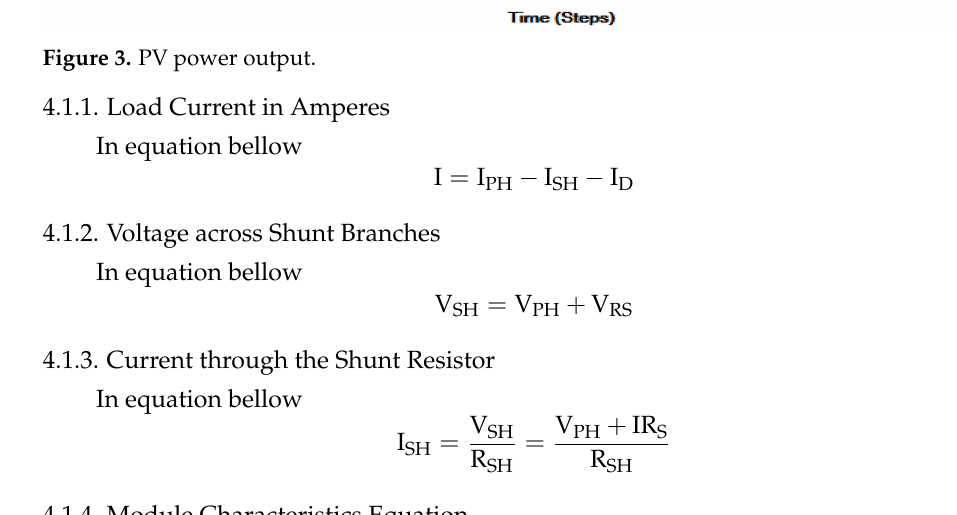
Figure 3. PV power